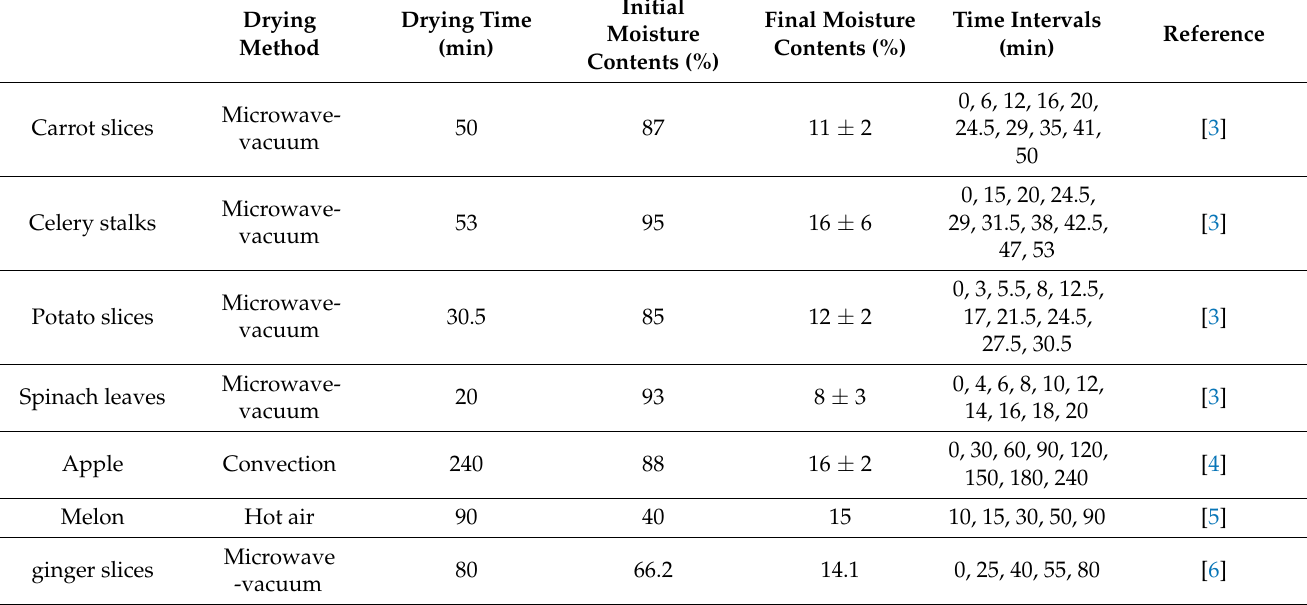
Table 1. The moisture content recommended for different crops during